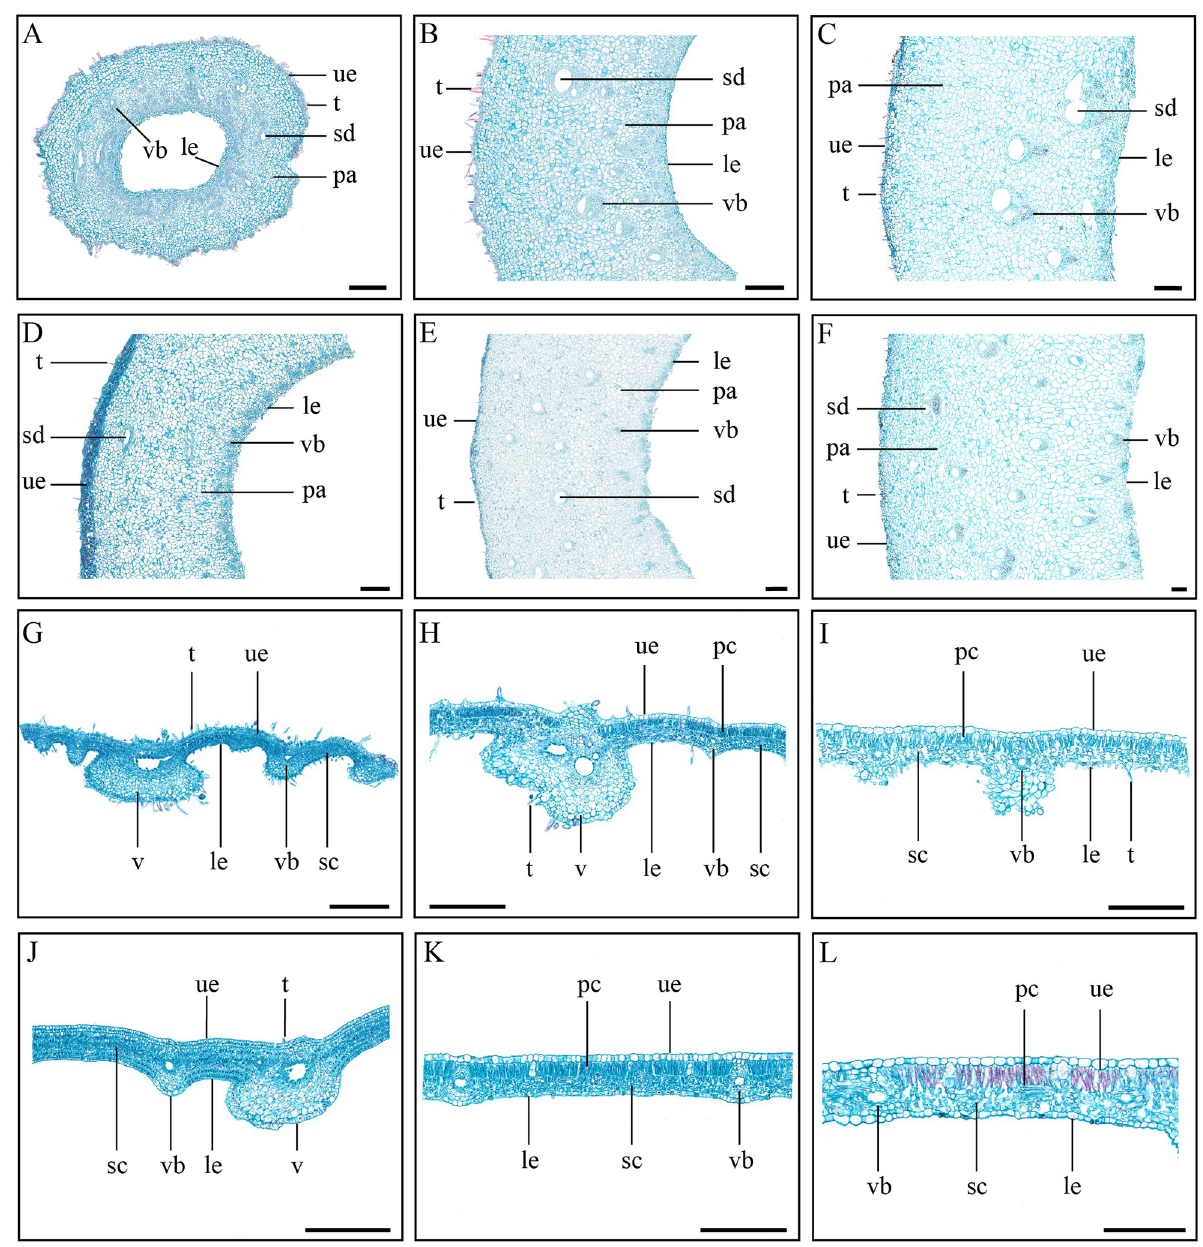
Fig 5. Histological profiles of galls and their host plant tissues. (A-C) Histological structure of horned gall at first, third, and fifth stage, respectively. (D-F) Histological structure of fusiform gall at first, third, and fifth stage, respectively. (G-I) Histological structure of R . chinensis leaflets at first, third, and fifth stage, respectively. (J-L) Histological structure of R . potaninii leaflets at first, third, and fifth stage, respectively. pa, parenchyma; sd, schizogenous duct; vb, vascular bundle; t, tomentum; pc, palisade cell; sc, spongy cell; le, lower epidermal cell; ue, upper epidermal cell; v, vein; Scale bars = 200 μ